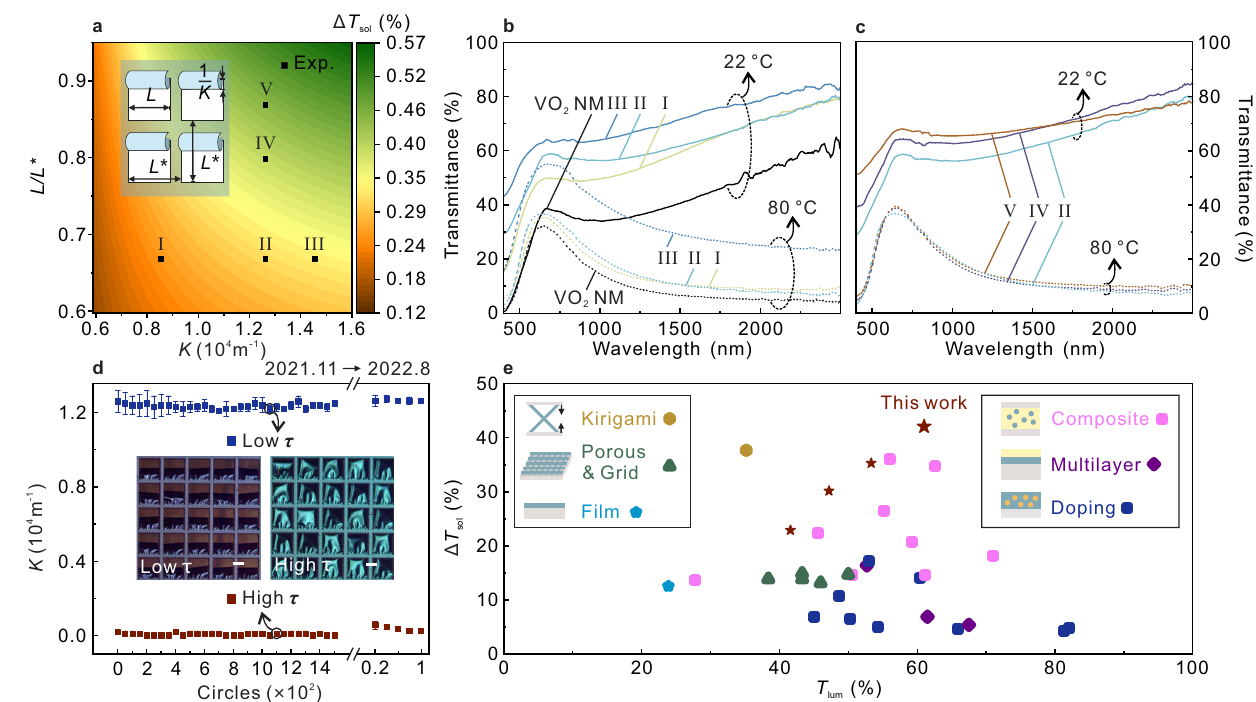
Fig. 4|Optimizationofrolled-upSWforenhancing T lum and Δ T sol .a Simulated at 1.26×10 4 m − 1 . d Fatigue tests of the rolled-up SWs switching between low τ and 4 T * . The solid points represent the high τ .Insetsarethemicroscopeimagesofrolled - upSWsatlow τ andhigh τ .Scale sol of rolled-up SW as functions of K and L/L parameters selected of rolled-up SW in the experiment. The inset is schematic of bar:100 μ m.Thecorrespondingerrorbarrepresentsstandarddeviation.25rolled- rolled-up structures. The length of rolled-up structures, L =200 μ m. up structures on sample IV after every 50 heating-cooling circles were measured b Transmittance spectra of the rolled-up SW with the K of 1.45×10 4 m − 1 (I), once and the results were used to calculate the standard deviation. e Comparison 1.26×10 4 m − 1 (II),0.85×10 4 m − 1 (III),and0(VO 2 NM)atdifferenttemperatures.The of this work with the best-reported experimental works regarding the T lum and 4 T L/L * is kept constant at 0.67. c Transmittance spectra of the rolled-up SW with L/L * sol , and the schematics of corresponding different types of VO 2 -based SW are displayed 5,13,17 – 19,38 – 59 . Source data are provided as a Source Data fi of0.87(V),0.80(IV),and0.67(II)atdifferenttemperatures.The K iskeptconstant